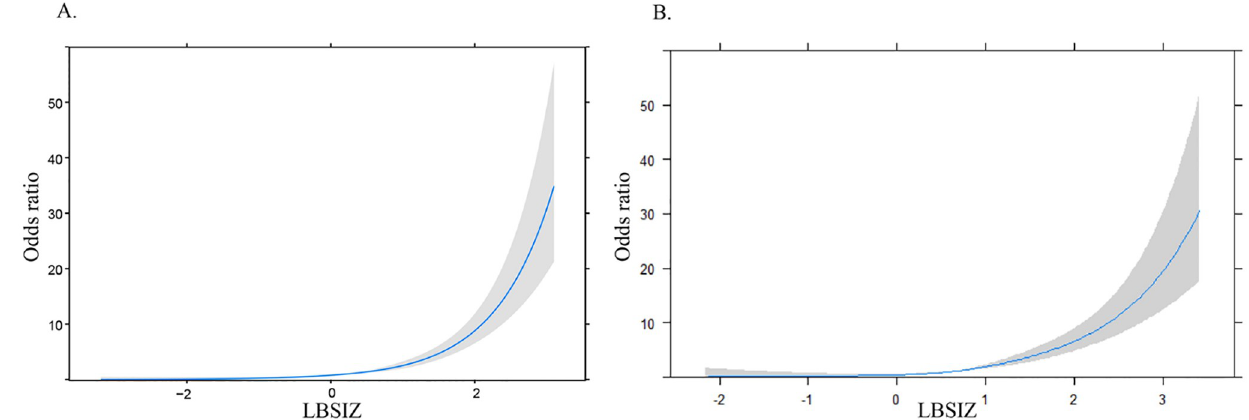
Fig 3. Relationship between LBSIZ and the odds ratio for sarcopenia according to sex. A. U.S. NHANES; B. KNHANES. Adjusted for age and sex. LBSIZ, z-score of the log-transformed A Body Shape Index.